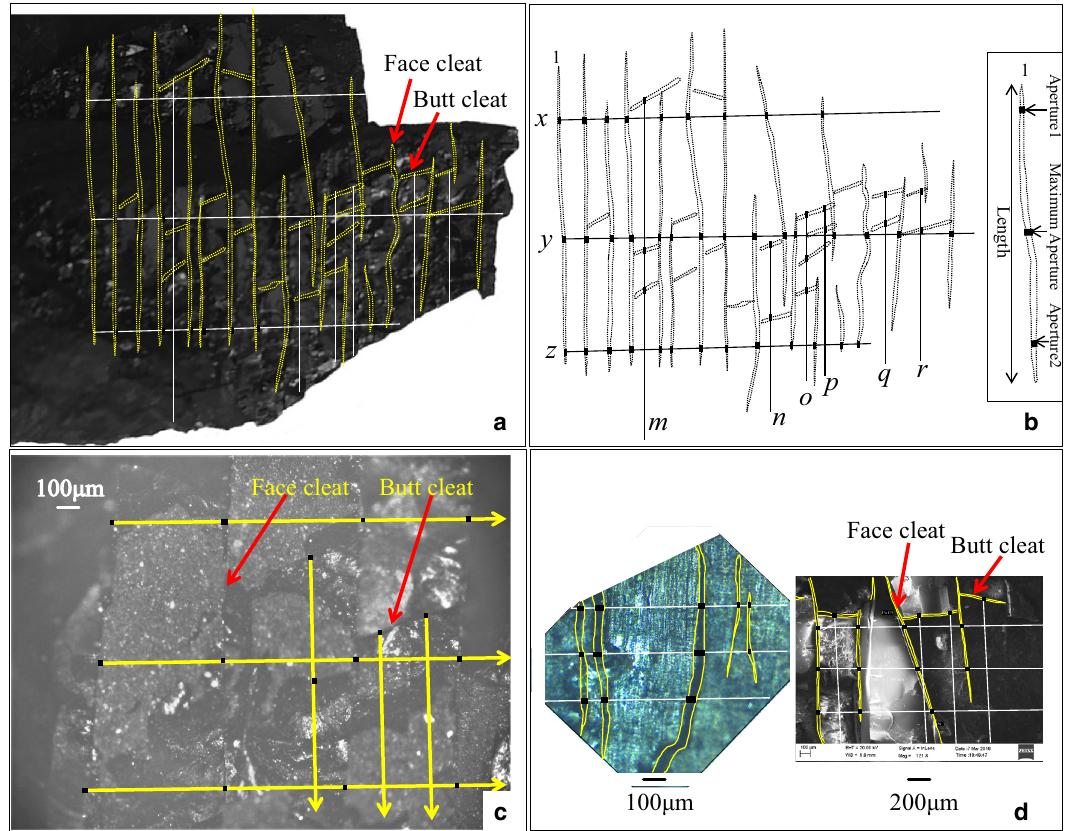
Fig. 5 Images of cleats from a a hand specimen chip from Narayankuri with superposed scanlines; b schematic cleat scanline (1D) diagram traced from ( a ) showing measurement methodology of cleat aperture and length. Inset showing an example: ‘cleat 1’ intersects the three scanlines x , y and z at three locations. Mean of aperture measurements at these three locations represent the average aperture of cleat1 and largest of them is D max ; c , d same as ( b ) under optical microscope and scanning electron microscope